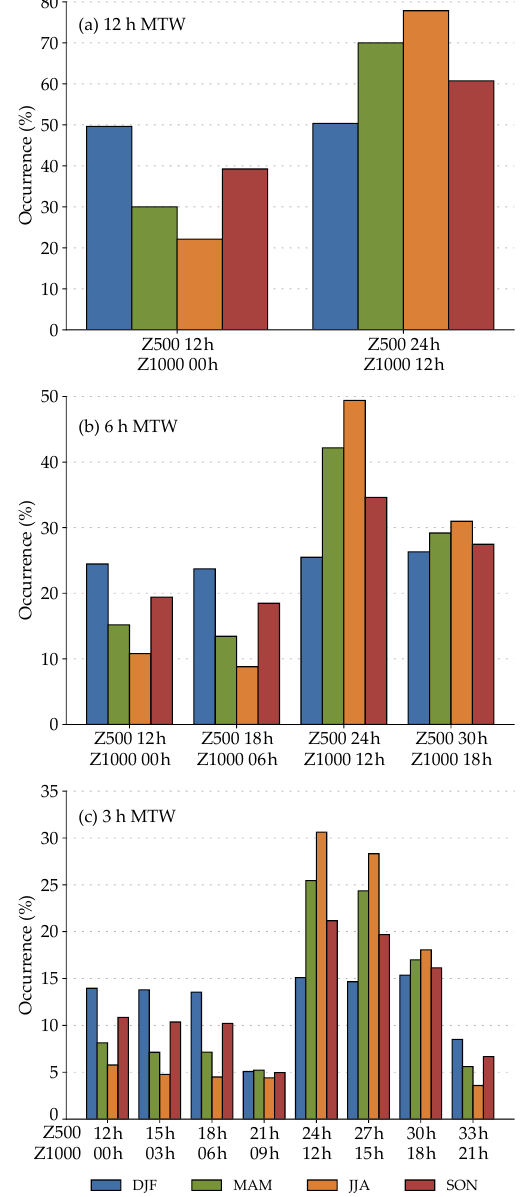
Figure 7. Distribution of the predictor hours on the selected ana- logue dates for the Ulrichen station when using a (a) 12h MTW, (b) 6h MTW, and (c) 3h MTW, depending on the season.